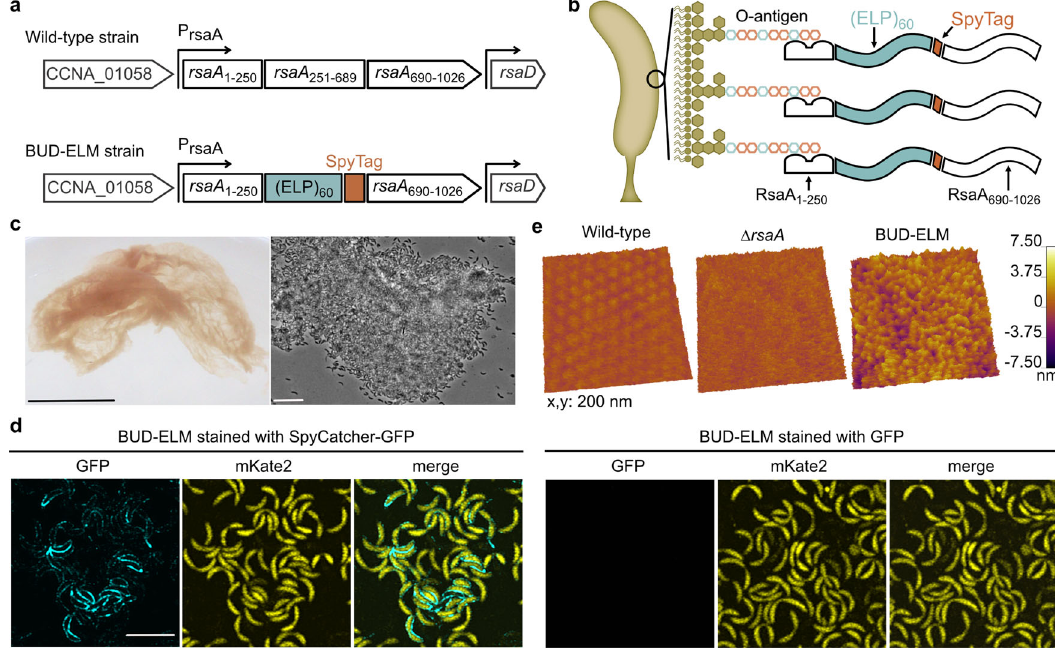
Fig. 1 | Engineered strains of C. crescentus self-assemble into